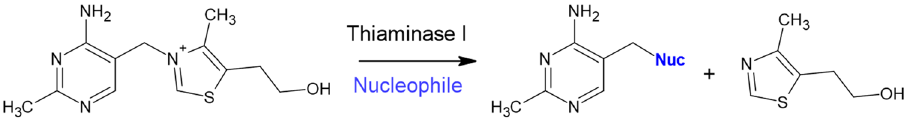
Figure 1. Cleavage of thiamine into pyrimidine and thiazole fragments in the presence of thiaminase I and nucleophilic